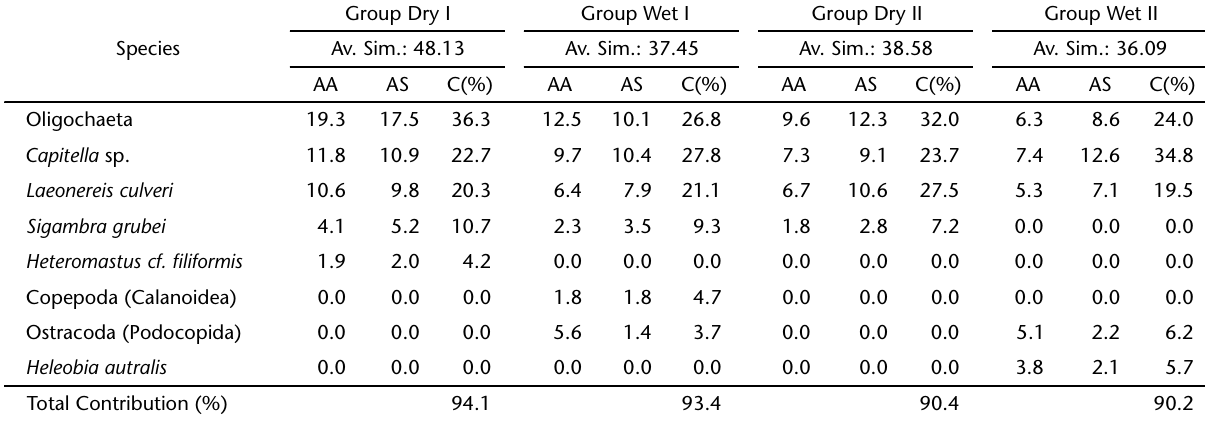
Table VI. SIMPER results showing the average abundance (AA) and similarity (AS) of species contributing (C) the most to each sampling period in SJLS.